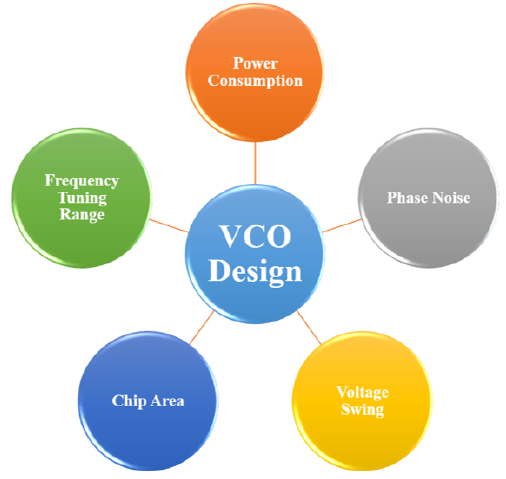
Figure 3. The VCO design trade-offs.